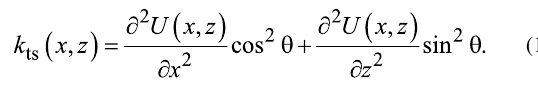
approaching a sample or determining the sample tilt. Here a complementary technique such as STM (used in our setup) or biaxial AFM with normal force detection is